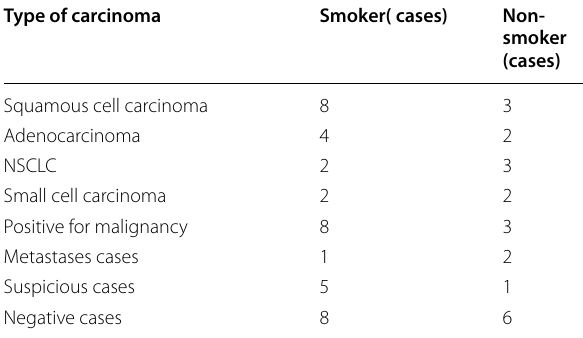
Table 2 Typing of lung carcinomas with respect to smoking habit